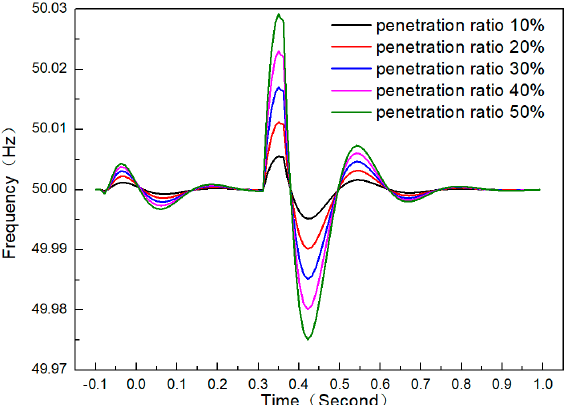
Figure 6. Effect of short-circuit events on node frequency.